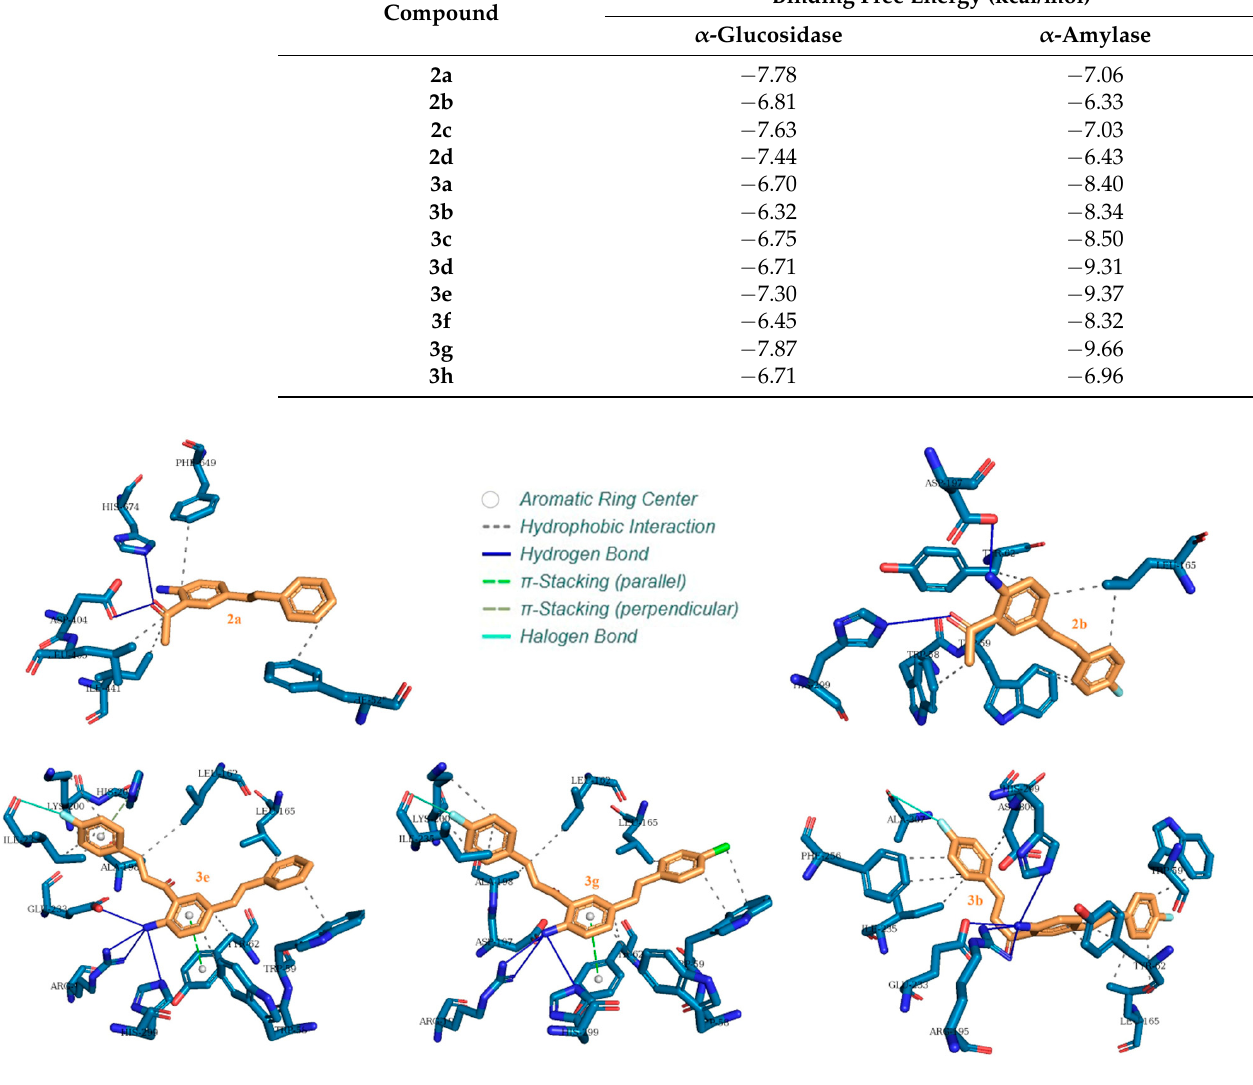
Figure 5. The interaction between the most ( 2a , 3e and 3g ) and the least ( 2b and 3b ) active compounds against α